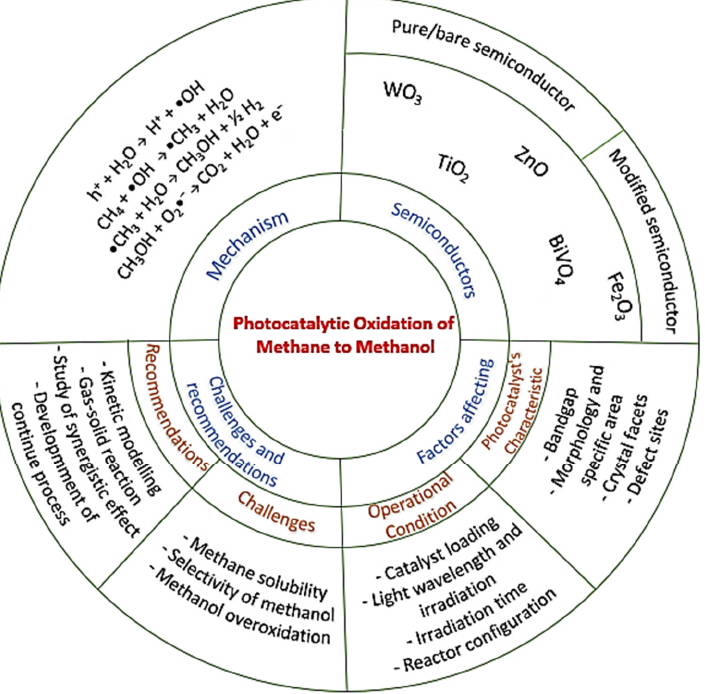
Figure 5. Schematic overview of photocatalytic oxidation of methane to methanol in this review